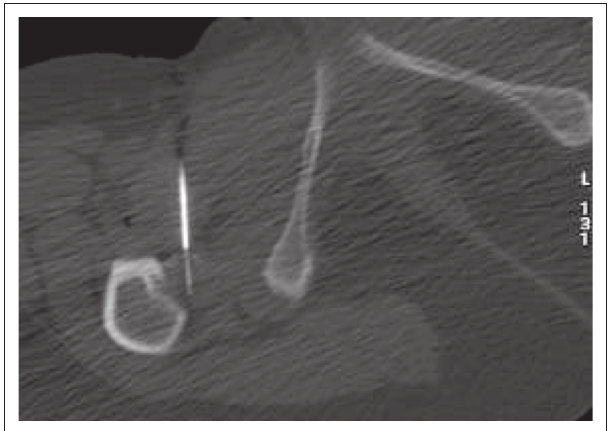
FIGURE 9: Ultrasound image of the liver demonstrating infiltrative angiomatous lesions in both liver lobes.